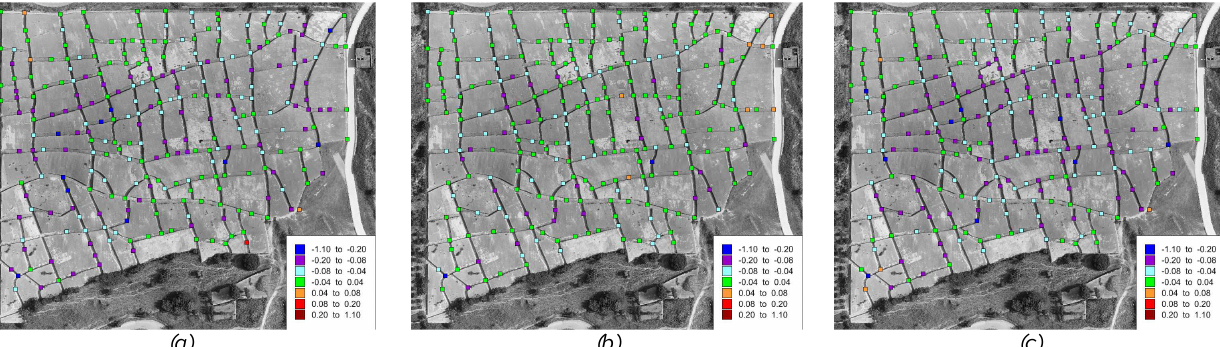
Figure 11. Graphic representation of the vertical differences (in m) in 3D point cloud evaluation for the “Cretto of Gibellina”: East- West Block (a) ; North-South Block (b) ; East-West + North-South Blocks